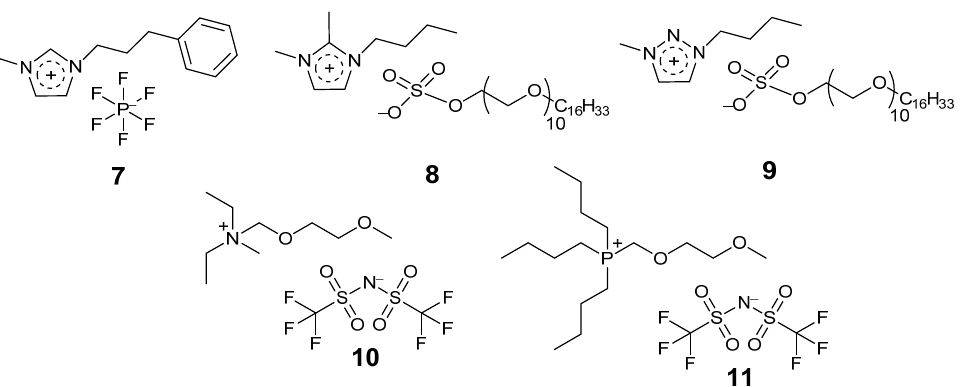
Figure 6. Structure of some ionic liquids ( 7 – 11 ) used for enzyme coating and storage. Itoh and co-workers have coated lipase from Pseudomonas cepacia within a surfactant containing imidazolium based ionic liquid [85,86]. The ionic liquid ( 8 , Figure 6) coated lyophilized enzyme was used to catalyse the transesterification of 1-phenylethanol and vinyl acetate in diisopropyl ether, achieving 49% conversion in 2 h, compared to 15% conversion in 26 h for the free enzyme. The enhancement in the rate of transesterification was dependent on the substrate type, a 1100 times rate acceleration was observed for 1-(Naphthalen-2-yl)propanol with vinyl acetate in diisopropyl ether at 35 ◦ C, whereas a 500 times rate acceleration was observed for 1-(Naphthalen-1-yl)ethanol. In addition, the ionic liquid coated enzyme was stable and retained full activity after storage in hexane for a week at room temperature, whereas the free enzyme lost activity completely. The immobilized enzyme was recycled for five times in the transesterification of 4-phenyl-3-butene-2-ol with vinyl acetate. The lyophilization and ionic liquid content were found to be critical for enzyme activity.